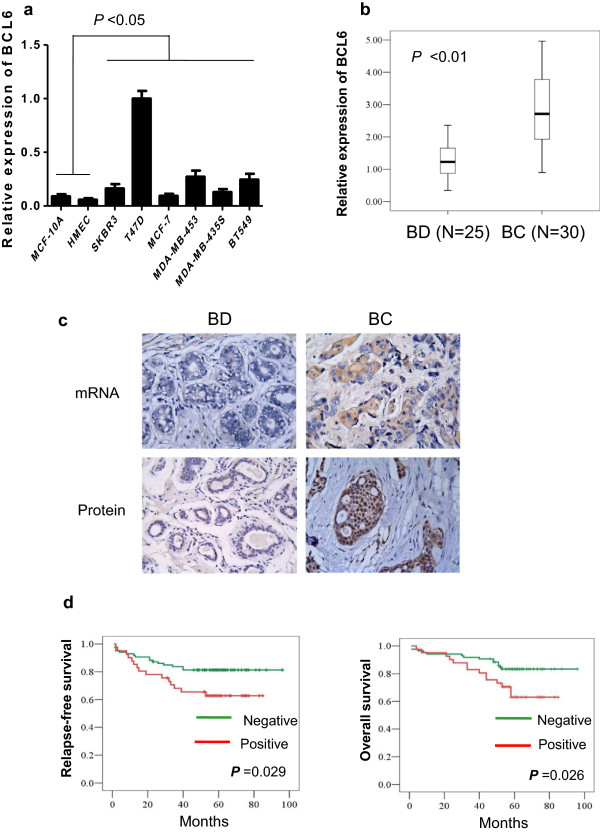
Expression of BCL6 mRNA and protein in human breast cancer cell lines and tissue specimens. (a) qRT-PCR. Level of BCL6 mRNA expression in eight human mammary cell lines was analyzed by qRT-PCR. (b) qRT-PCR. Levels of BCL6 mRNA expression were examined in 30 breast cancer (BC) and 25 breast benign disease tissue specimens (BD) by qRT-PCR. (c) Representative imagines of BCL6 expression analyzed by in situ hybridization and immunohistochemistry (Magnification: ×400). (d) Kaplan-Meier curve of the relapse-free survival (RFS) or overall survival (OS) according to BCL6 expression.